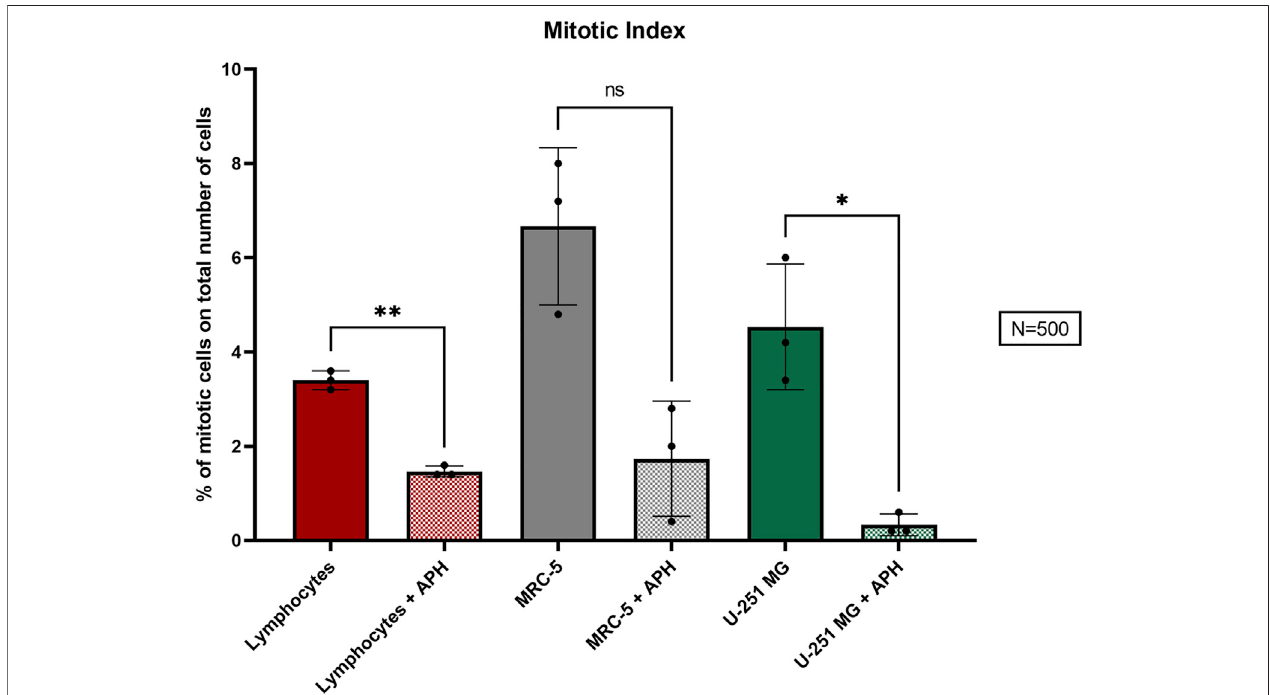
FIGURE 1 | Percentage of the M.I. (mitotic index) in the three cell types, lymphocytes (red), MRC-5 fi broblasts (gray), and U-251 MG GBM cells (green) in control and APH-treated conditions. The color coding of the three cell types is maintained throughout the fi gures. The error bars represent the standard deviation (SD) determined from 3 independent experiments ( N (cid:1) 500 cells for each replicate). Paired t -test wasused tocalculatethe p values, where p > 0.05 ns, * p ≤ 0.05, ** p < 0.01, *** p < 0.001, and **** p <